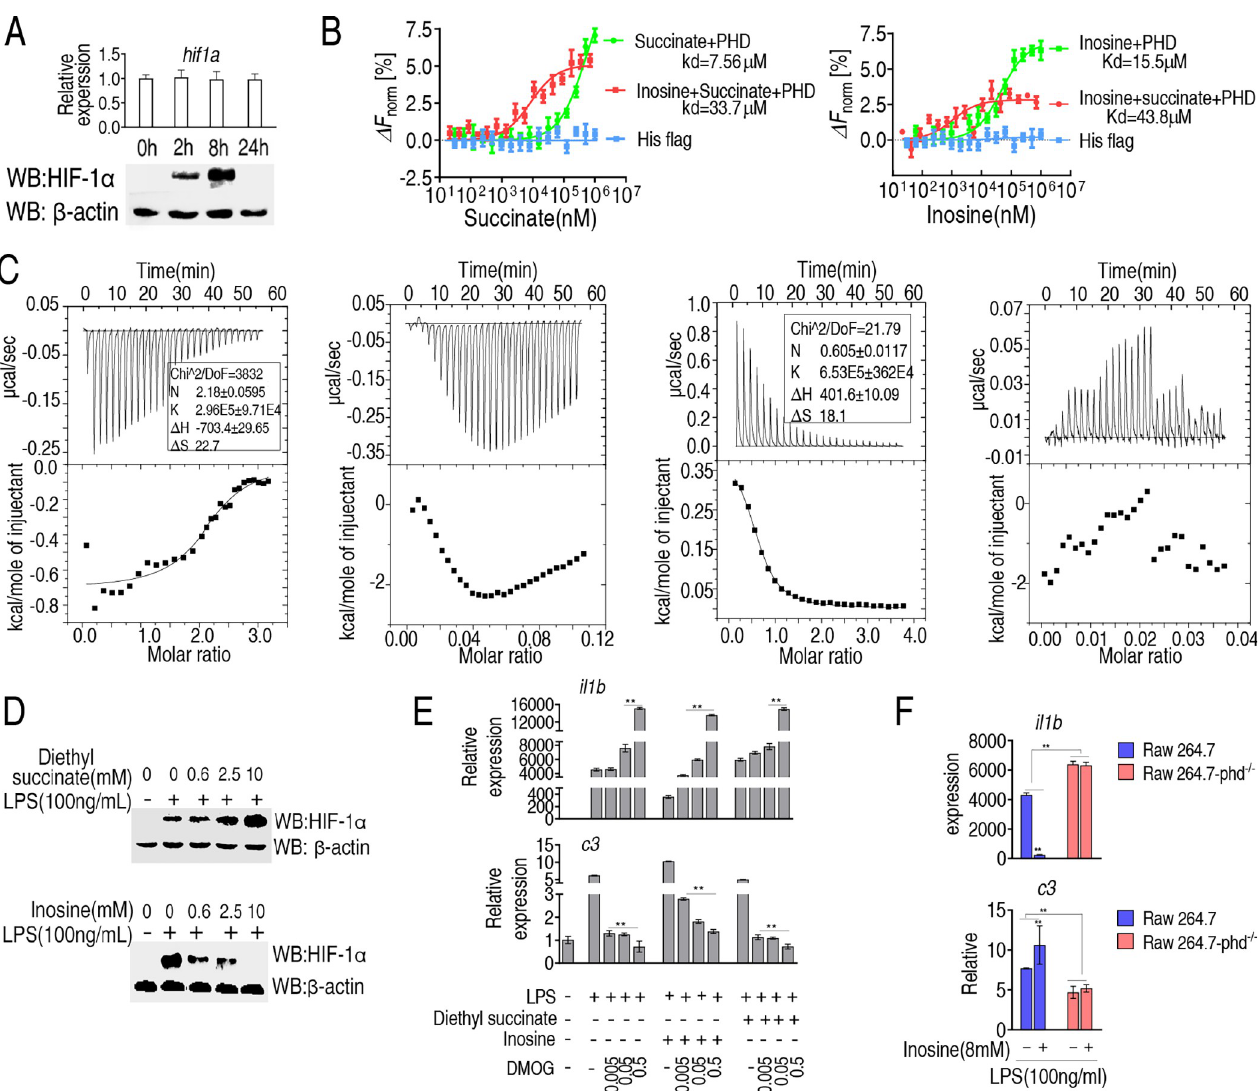
Fig 4. Interactions between PHD, succinate and inosine and impact on HIF 1- α protein abundance. A, qRT-PCR for transcript abundance and Western blot for abundance of HIF 1- α protein at the indicated time points after treatment with LPS. B, MST analysis of PHD plus succinate and/or inosine. C, ITC curves for the binding of succinate (the first panel) or in the presence of inosine (the second panel) or inosine (the third panel) or in the presence of succinate (the forth panel) to PHD. The top panels showed data obtained from automatic injections after baseline corrections. The bottom panels showed the integrated curve that was fitted into a sequential two-site binding model. K: association constant; N: reaction stoichiometry; Δ S: entropy; Δ H: enthalpy. D, Western blot for HIF 1 α protein in the presence of succinate or inosine at the indicated doses plus LPS stimulation. E, Transcripts for il1b and c3 in cells exposed to LPS, inosine, succinate and the indicated concentration of DMOG. F, Effect of PHD knock-out on il1b and c3 expression in LPS-treated macrophages in the presence or absence of exogenous inosine. Results (E-F) are displayed as mean ± SEM, and significant differences are identified ( � p < 0.05, �� p < 0.01) as determined by non-parametric Kruskal-Wallis one-way analysis with Dunn multiple comparison post hoc test for results.